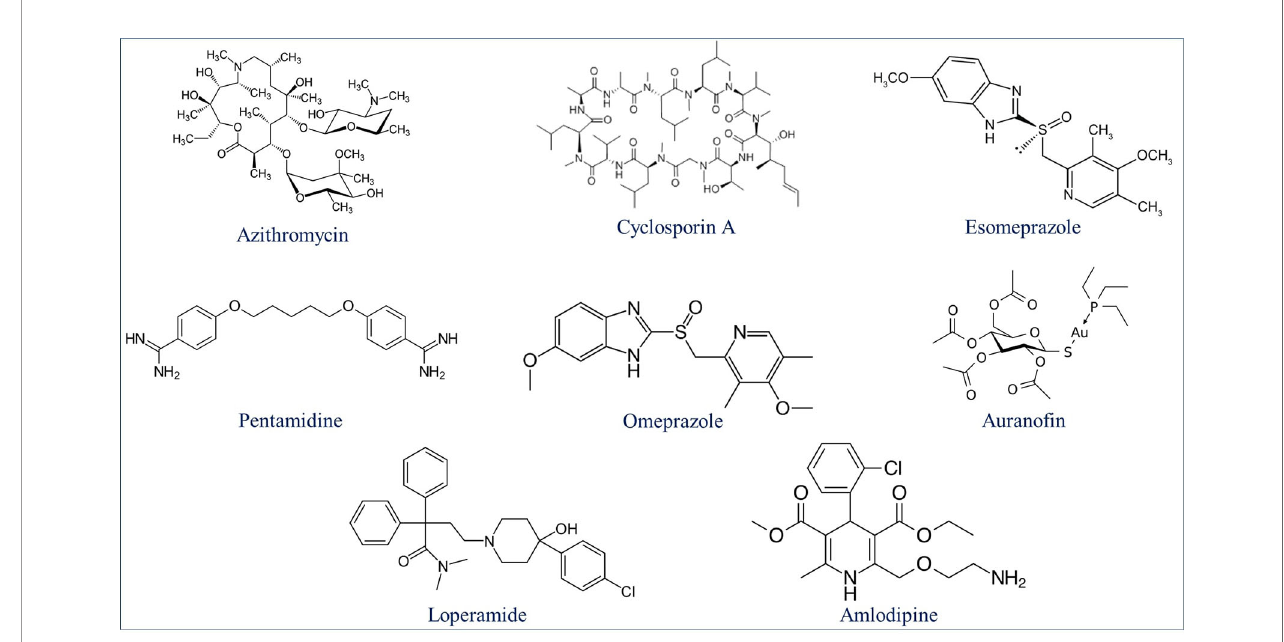
FIGURE 8 | Eight drugs suggested by Pazhayam et al. (2019) with probable antimalarial activity. DeepMalaria was able to predict all scaffolds as hits for Plasmodium